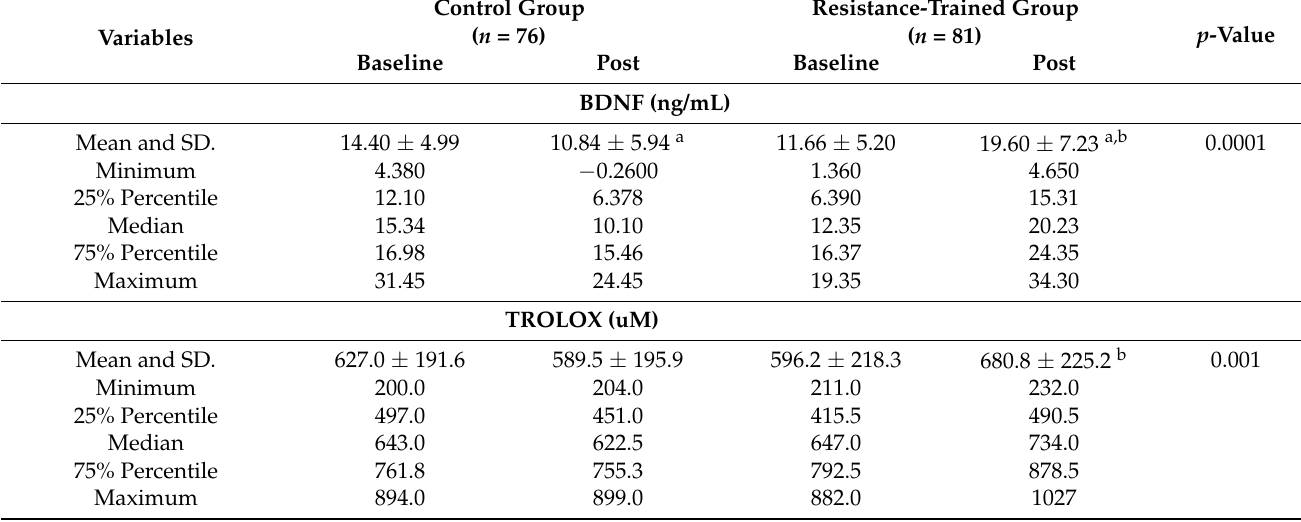
Table 3. BDNF levels redox balance profile and handgrip strength at baseline and post-training between CTL and RT